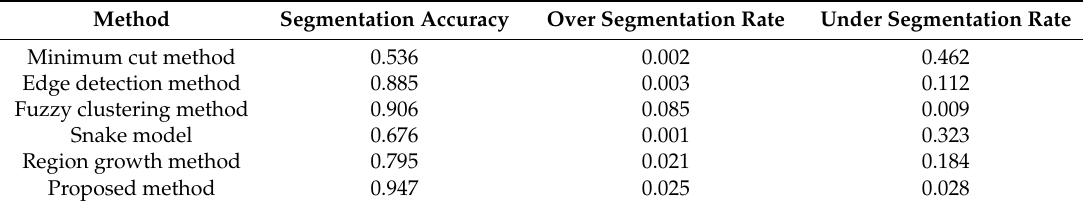
Table 7. Segmentation accuracy of different segmentation